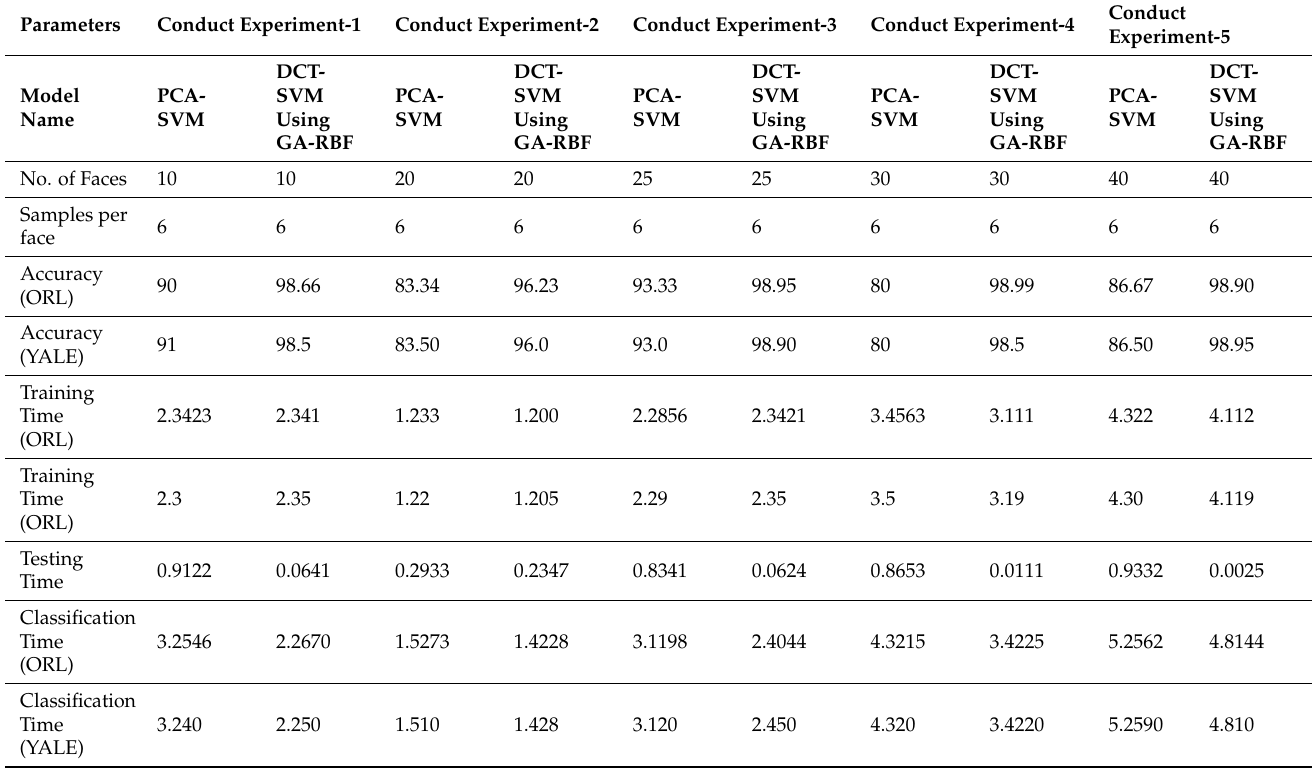
Table 3. Results analysis using PCA-SVM and DCT-SVM using GA-RBF.